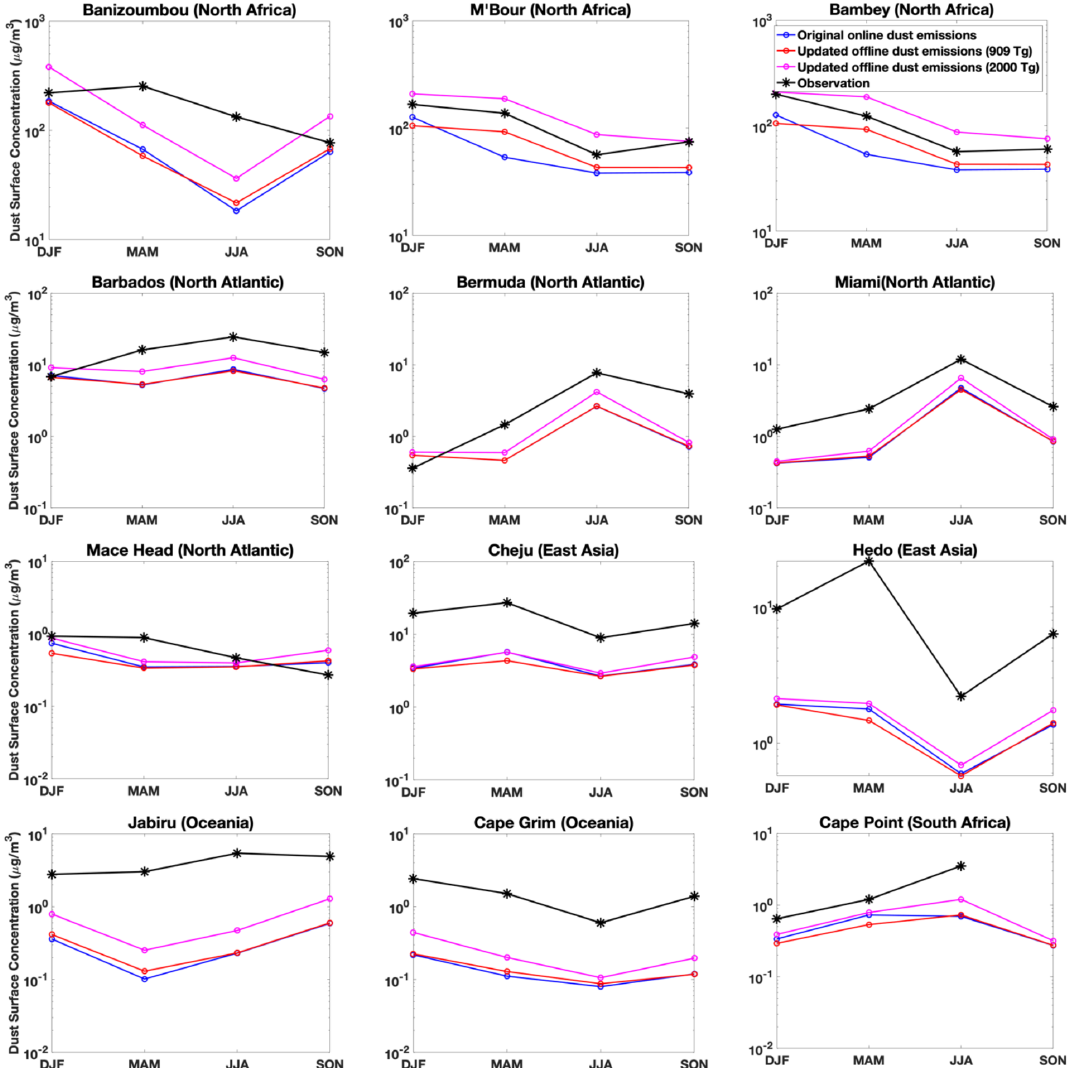
Figure 6. Comparison of modeled and measured seasonally averaged surface dust concentrations at 12 independent globally distributed sites for the years 1981–2000. Nine sites are in the dust belt across Northern Hemisphere. The remaining 3 sites are relatively close to the weak dust emission regions in Southern Hemisphere. The results for the simulation using the original dust emissions are shown in blue. The results for the simulation using updated dust emissions with dust strength of 909Tgyr − 1 are shown in red. The results for the simulation using updated dust emissions with dust strength of 2000Tgyr − 1 are shown in magenta. The measurements are in